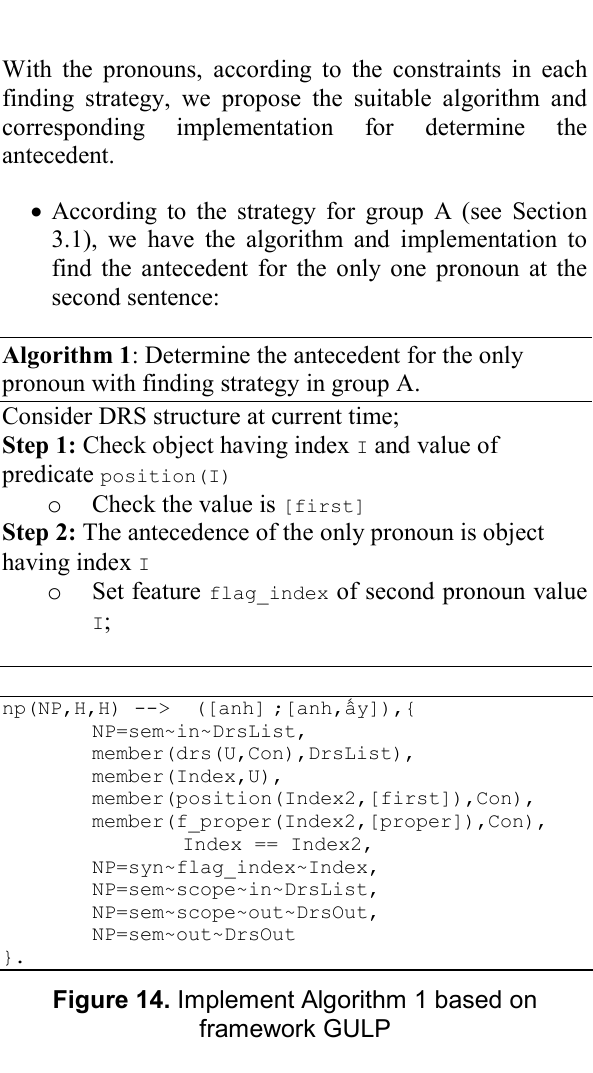
Figure 12. Describe transitive verb “đánh” (example 14) in group D based on framework GULP